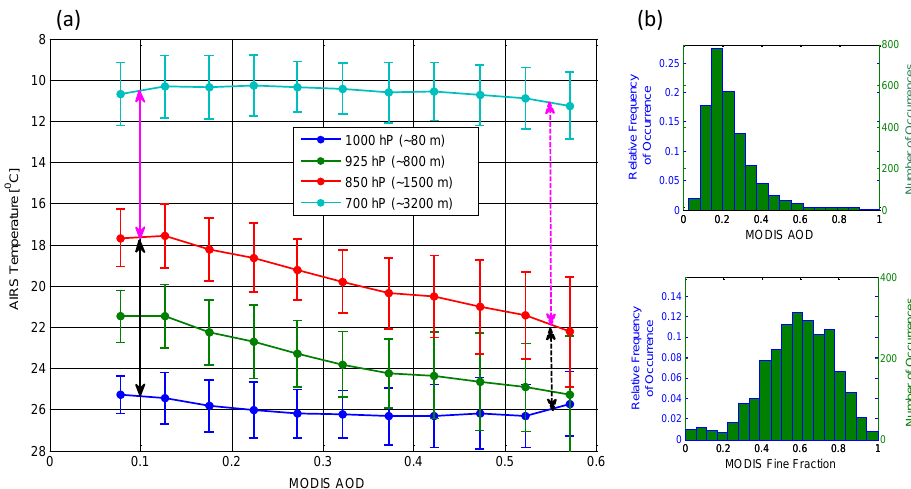
Figure 10. (a) MODIS AOD 550 vs. AIRS temperature at four different pressure levels (1000, 925, 850 and 700hPa) for summer 2010. The vertical axis is in reverse order. The bold and dotted black arrows represent temperature differences between 850 and 1000hPa levels (stability parameter) in cases of clean and hazy atmosphere, respectively. Similarly, the pink arrows show temperature differences between 700 and 850hPa levels. The AIRS temperature data are sorted according to AOD and divided into equal spaced bins of 0.05 AOD 550 . Error bars present the standard deviation of points in each bin. (b) Relative frequency distribution of occurrence (blue bar lines are relative frequency and green are number of occurrence, both are scaled) of AOD (upper panel) and ff (lower panel) for all observed data over the ROI.